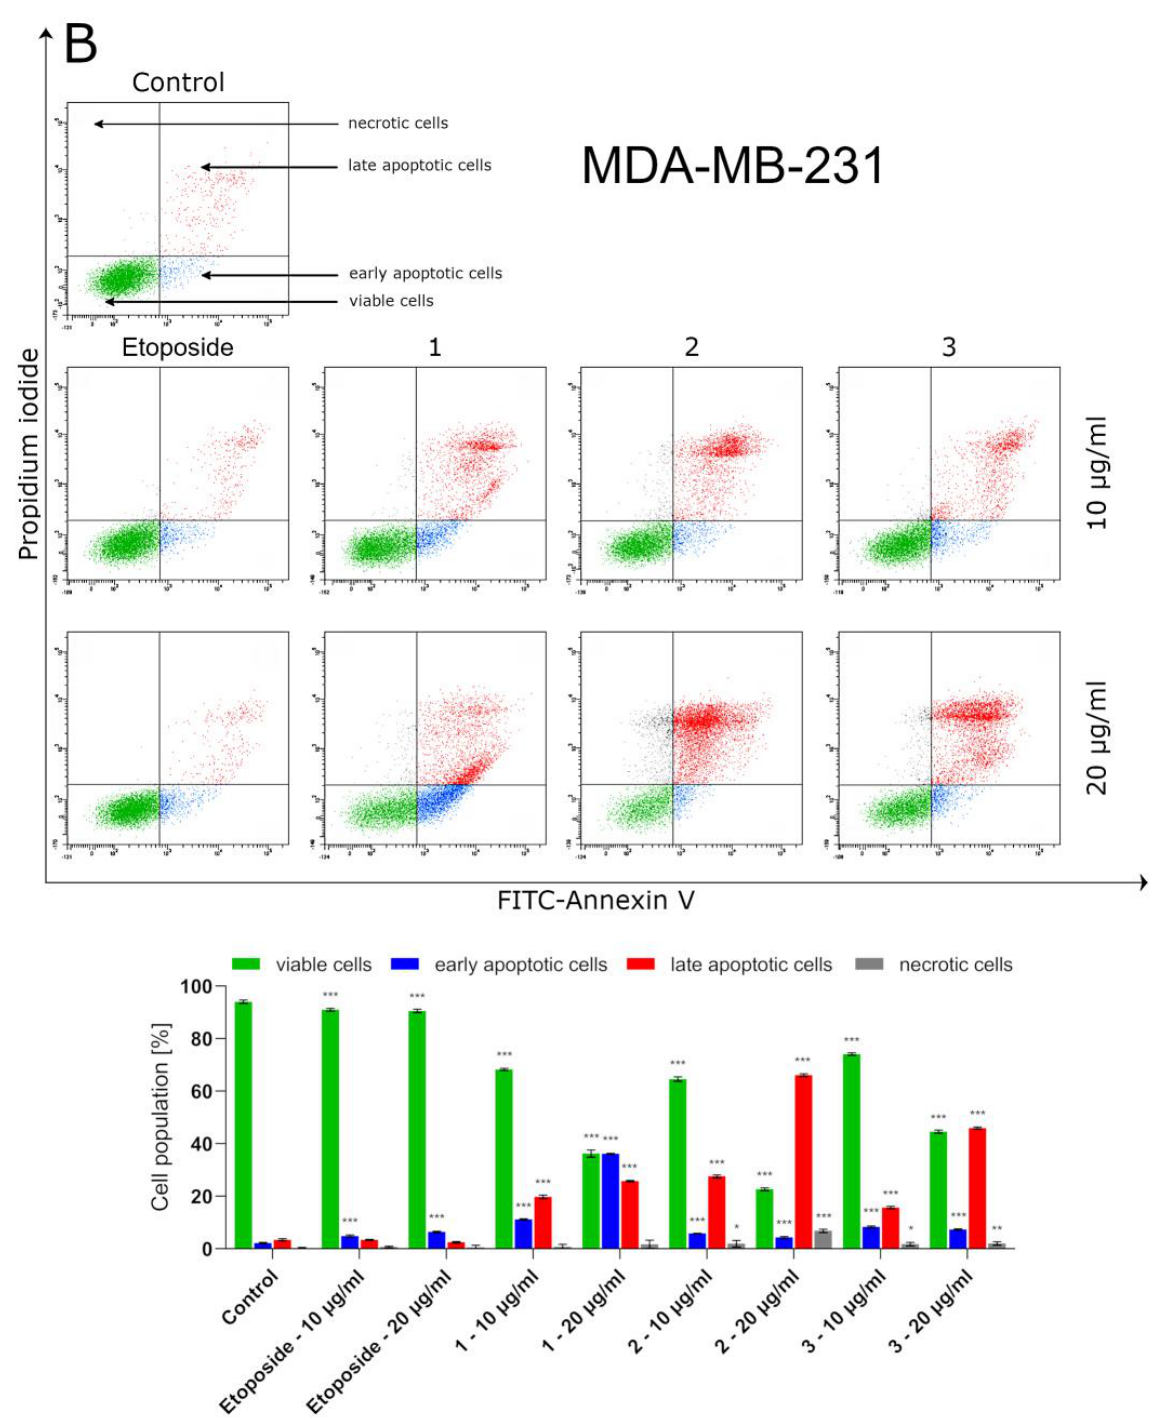
Figure 2. Flow cytometry analysis of MCF-7 ( A ) and MDA-MB-231 ( B ) breast cancer cells after 24 h incubation with compounds 1 – 3 and etoposide, and subsequent staining with Annexin V and propidium iodide. The compounds were tested at the following concentrations: 1 (10 µ g/mL/23.83 µ M and 20 µ g/mL/47.66 µ M), 2 (10 µ g/mL/22.75 µ M and 20 µ g/mL/45.50 µ M), 3 (10 µ g/mL/23.78 µ M and 20 µ g/mL/47.56 µ M) andetoposide (10 µ g/mL/17 µ M and 20 µ g/mL/34 µ M). Mean percentage values from three independent experiments (n = 3) performedin duplicate are presented. * p < 0.05 vs. control group,** p < 0.01 vs. control group, *** p < 0.001 vs. control group. 2.4. Effect of Compounds 1 – 3 and Etoposide on Caspase-8 and Caspase-9 Activity Caspases-8 and -9 are known as initiators of the apoptosis process. However, while activation of caspase-8 is a crucial step in the initiation of the death-receptor-mediated pathway of apoptosis (extrinsic pathway), caspase-9 plays a pivotal role in the intrinsic pathway mediated by mitochondria. Flow cytometric analyses showed that the reference drug (etoposide) statistically significantly increased caspase-8 activation in breast cancer